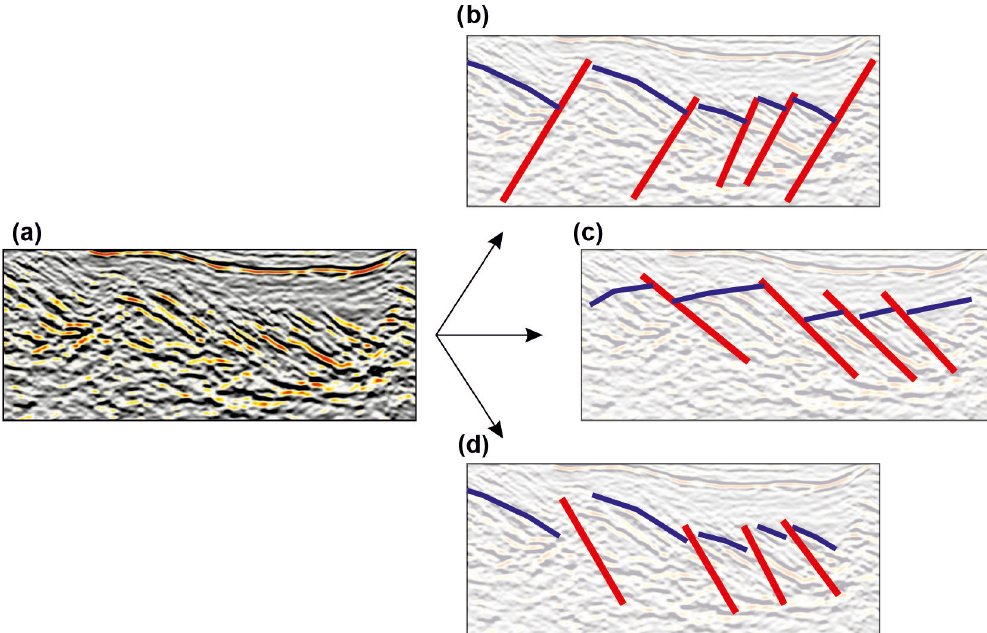
Figure 3. The seismic section and sketch interpretations of the three interpretation models applied in interpretations of the seismic section (a) by participants: (b) left-dipping normal faults (in red) with right-dipping horizons (in blue), (c) right-dipping normal faults with left-dipping horizons, and (d) right-dipping reverse faults with right-dipping